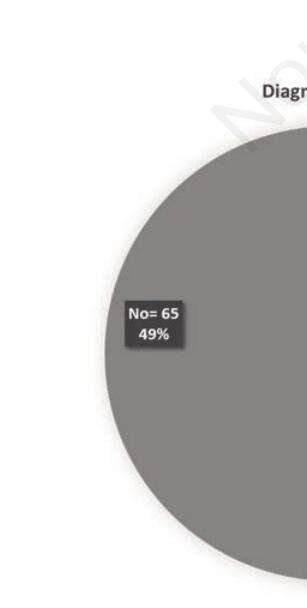
Figure 6. Number of diagnosis